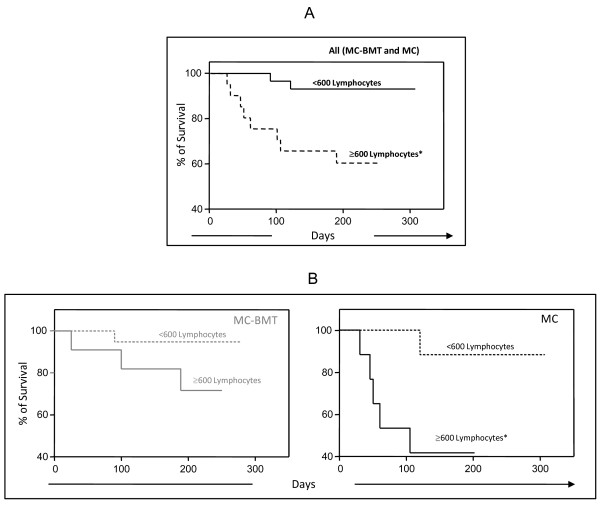
Survival rates of animals with canine mammary carcinoma. Kaplan-Meier survival curves for All (MC-BMT and MC) animals (A) categorized according to the lymphocytic infiltrate intensity (<600 and ≥ 600 lymphocytes) further sub grouped according to the histological diagnosis (MC-BMT or MC) (B) (bottom panels). Animals were submitted to quarterly follow-ups during twelve months and survival rates expressed in days between the surgical excisions of the end of follow-up as described in Methods. The survival curves were estimated with the Kaplan-Meier method followed by Log-rank test and significant differences at p < 0.05 highlighted by asterisk.